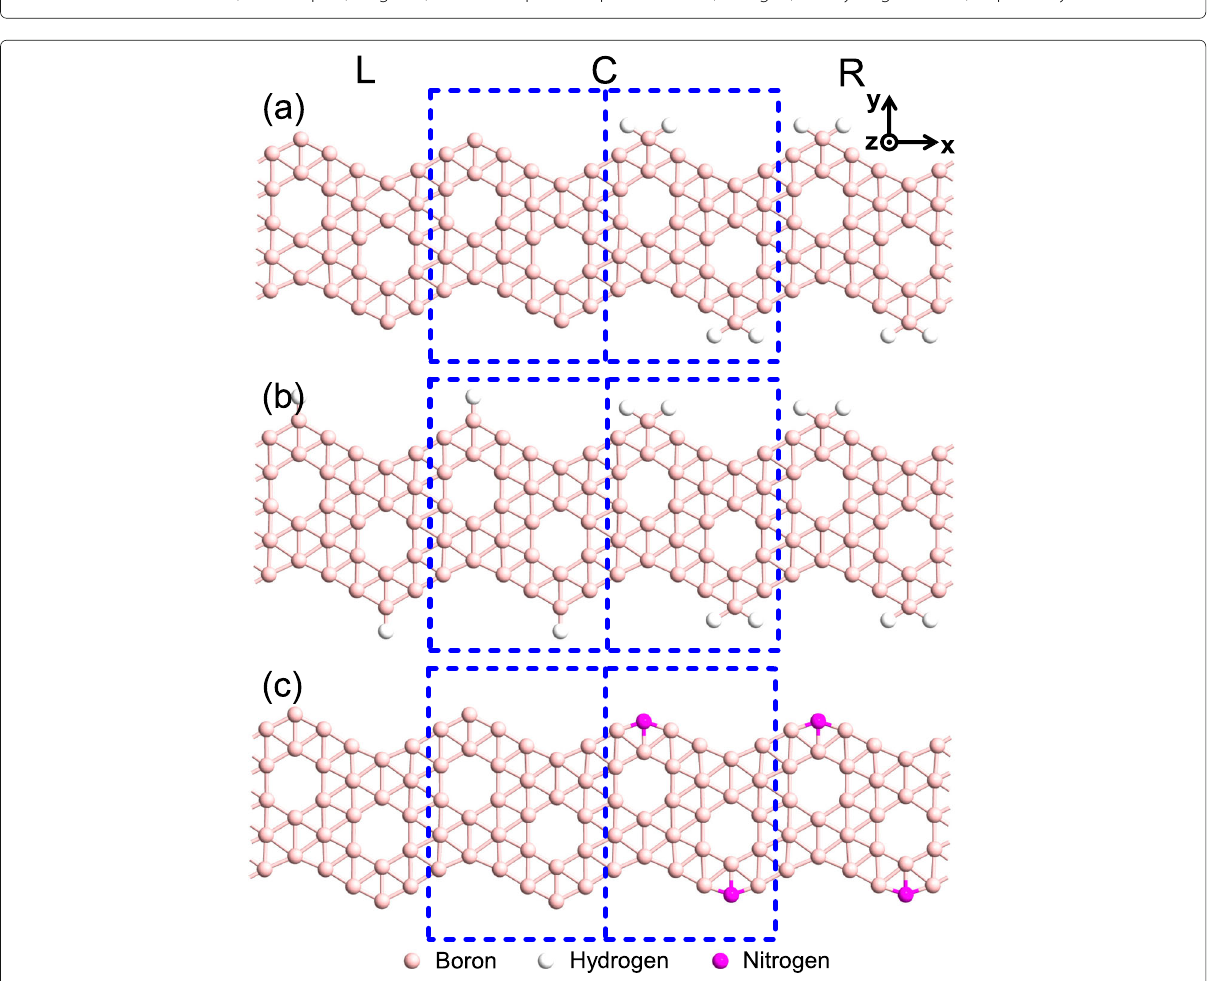
Fig. 2 The geometry structures of the proposed three types of model junctions, where a for M n H, b for M’ n H, and c for M n N, in which n represents the number of unit cells of the semiconductor part in the central scattering. The large (blue) dashed frame represents the central scattering region in which the small one indicates the unit